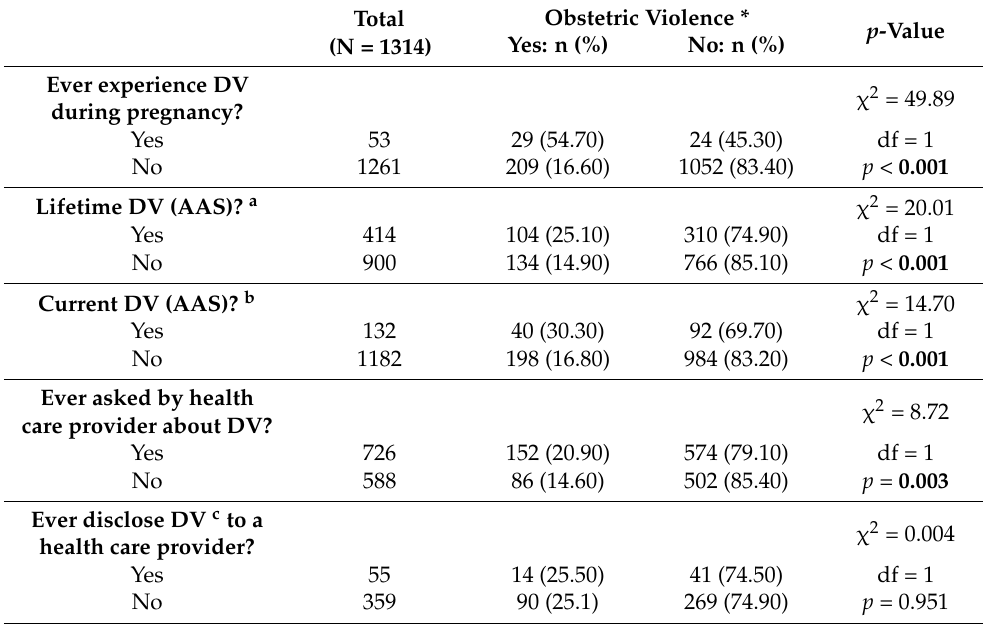
Table 3. Domestic violence compared with obstetric violence experiences.